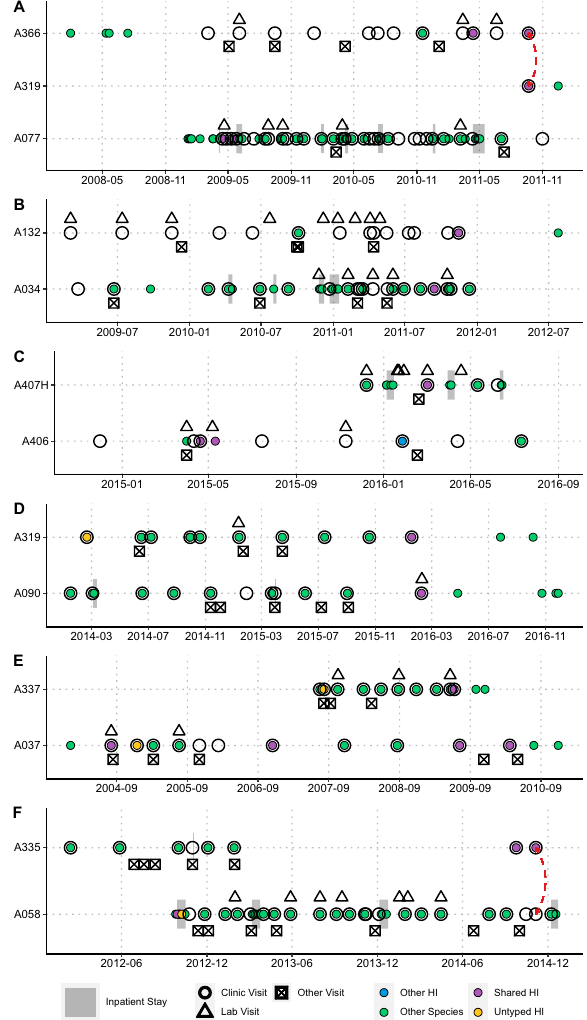
Figure 5. Epidemiological encounter timeline plots—potential for infection transmission events. ( A ) ST-12, ( B ) ST-103, ( C ) ST-145, ( D ) ST-321, ( E ) ST-393, ( F ) ST-1034. pwCF identifiers are given as “A###” on the y-axis. Dates are represented on the x-axis. Sputum cultures are represented by colored circles; color of circle denotes whether that culture contained a shared HI strain (purple), a different HI strain (blue), an untyped HI strain (yellow), or no HI (either culture negative or any other CF pathogen (green)). Clinical encounters are represented by empty black shapes; a circle represents a clinic visit, a triangle represents a lab visit, and an X’d square represents a different type of visit. Grey bars represent in-patient stays. Red arrows indicate dates when involved patients had the same type of clinical encounter on the same